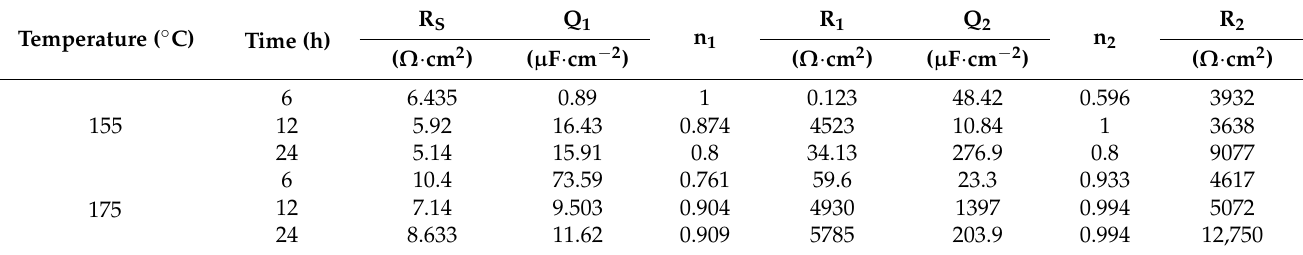
Table 2. Parameter fitting results of equivalent circuits.